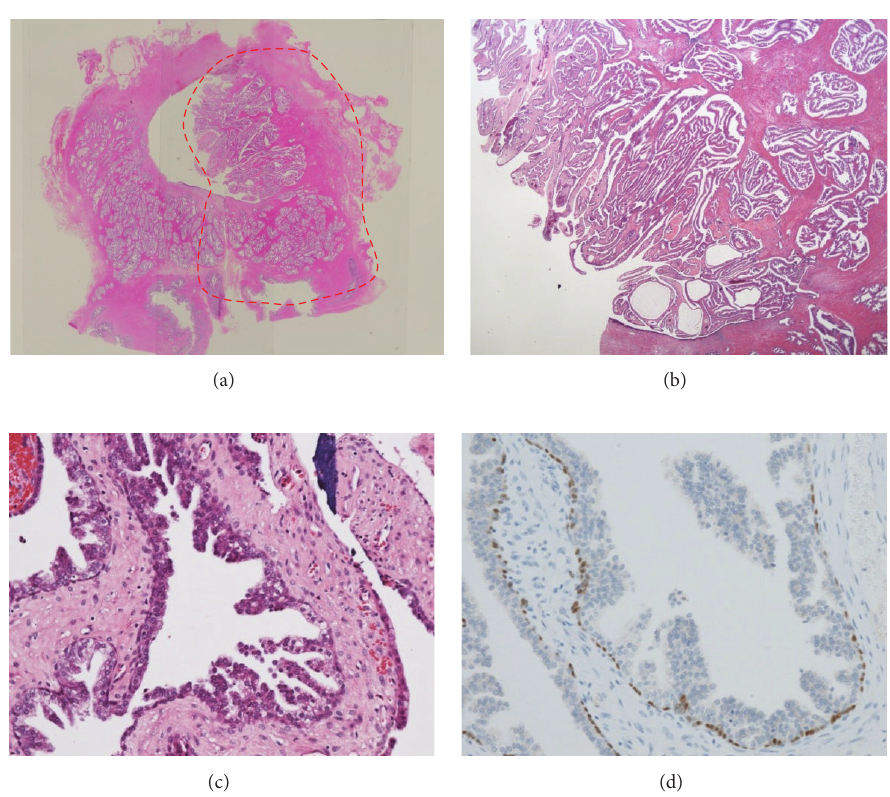
Figure 5: Pathological findings of the specimen obtained from radical prostatectomy ((a) × 4, (b) × 40, and (c) × 400). The pathological finding was that epithelial cell proliferations without nuclear enlargement were frequently seen in the tumor of the prostate. It was just like benign epithelial hyperplasia and there was no evidence suggesting malignant tumor. Immunohistochemical pathology revealed that basal membranes were preserved by p63 staining and few cells were stained by p504S (d), suggesting that the tumor was not